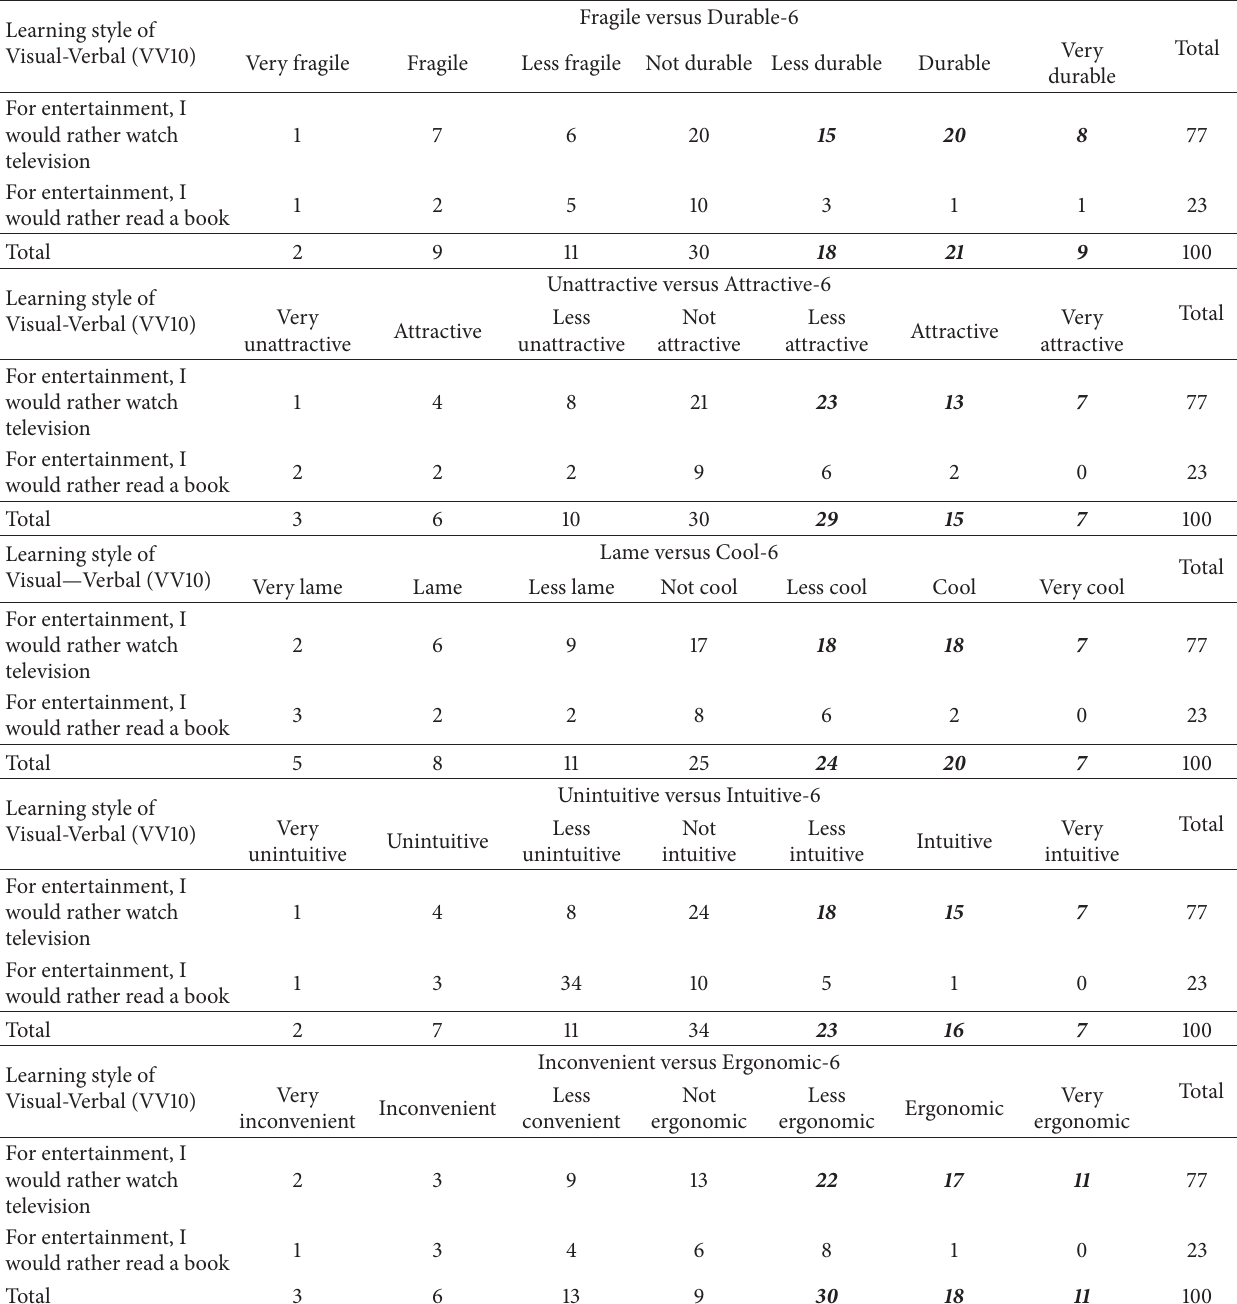
Table 22: The interpretation of Design no. 6 versus the the students’ Preferences related to the entertainment (VV10). (Based on Kansei words of Fragile-Durable, Unattractive-Attractive, Lame-Cool, Unintuitive-Intuitive, and